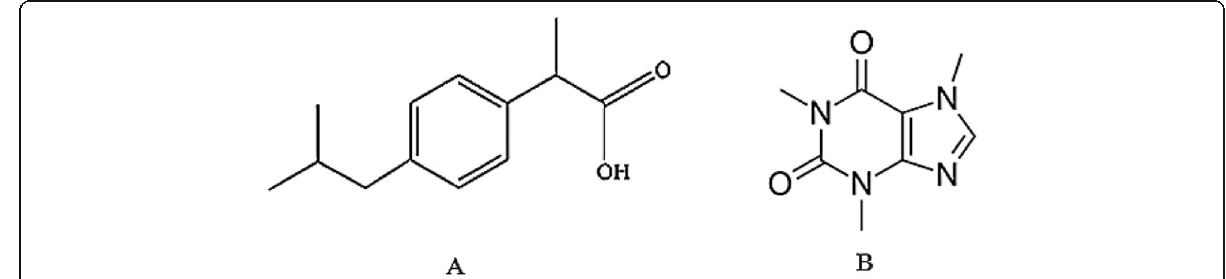
Fig. 1 Chemical structures of IBU ( a ) and CAF ( b